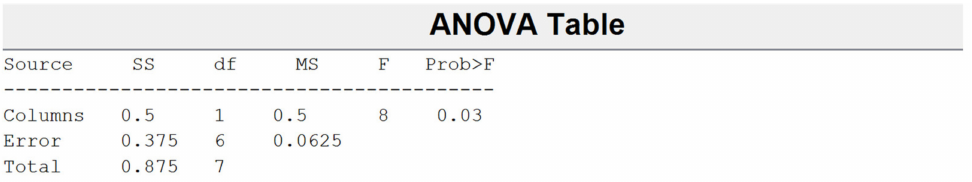
Figure 7. ANOVA analysis results for printed